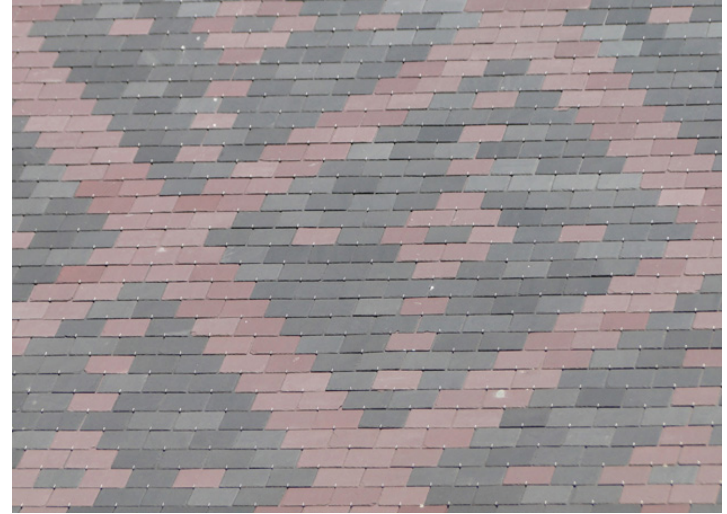
Figure 5. The partly filigree slate coverings of ornaments with round forms in Central Europe require well workable slates; four different deposits and varieties: ( a ) black, hard , Upper Devonian; ( b ) black, with carbonate, Middle Devonian; ( c ) green, with carbonate, Middle Devonian; ( d ) purple, hard Lower Devonian; (slate covering at least 90 years old).